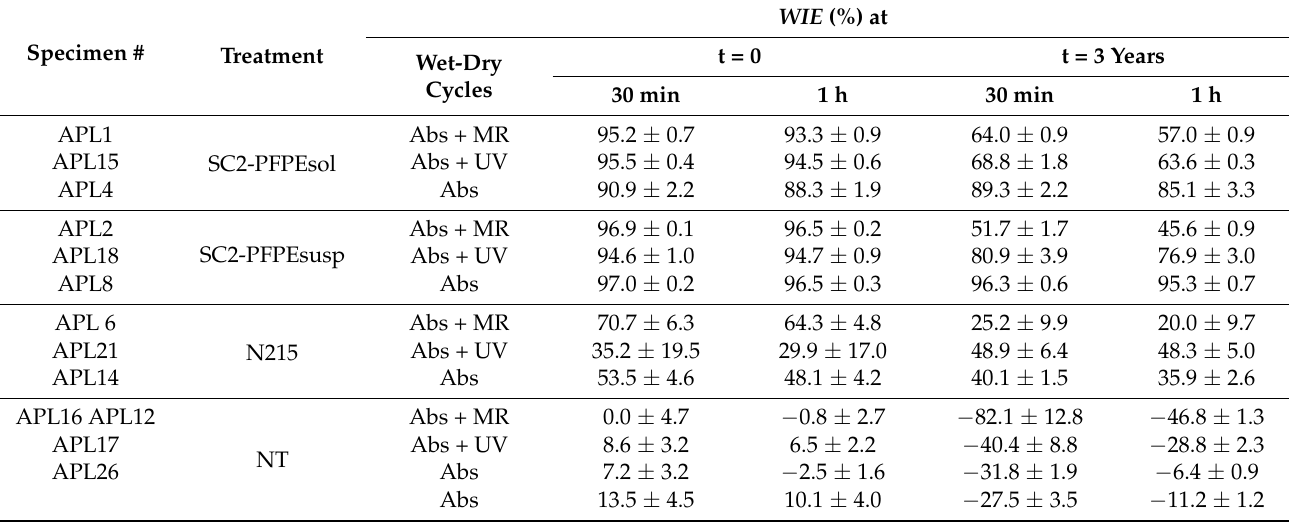
Table 4. WIE of fluorinated coatings on Lecce stone specimens after different wet-dry aging conditions. WIE was determined after 30 min and 1 h of capillary water